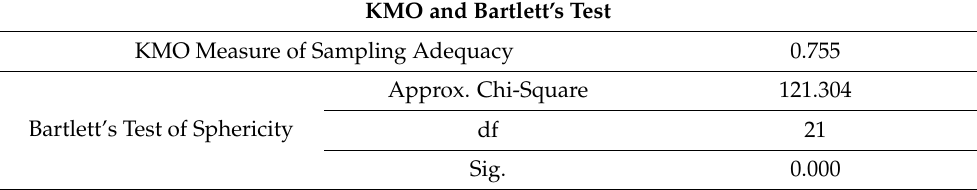
Table 8. KMO and Bartlett’s test results.